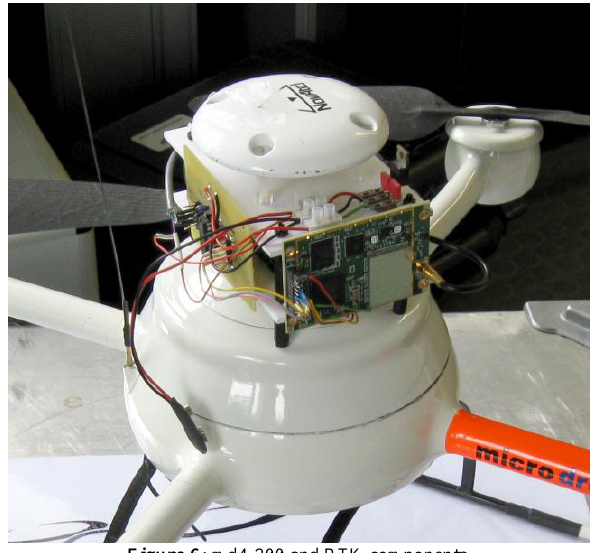
Figure 6: md4-200 and RTK components.